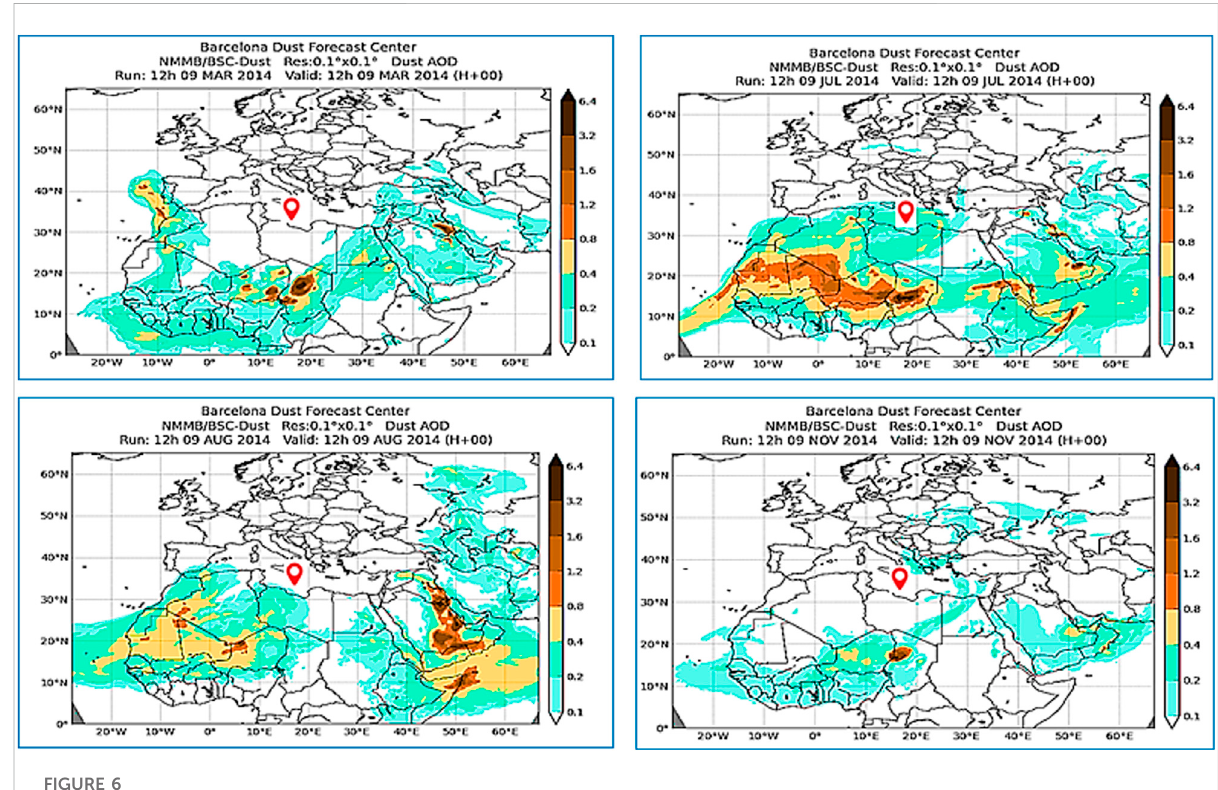
FIGURE 6 Optical depths of aerosols in the selected representative